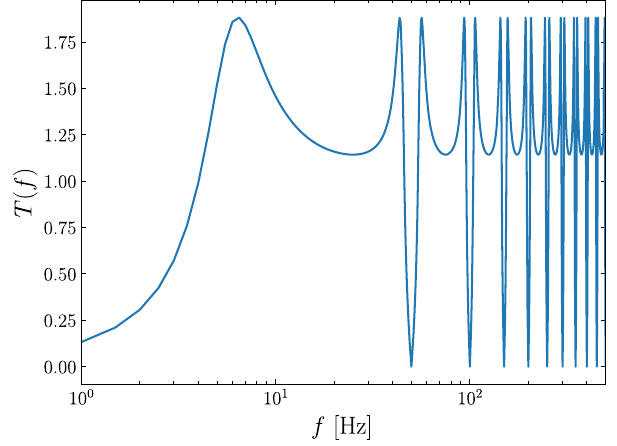
FIG. 9. Transfer function of the beam-based feedback system T ð f Þ vs frequency f .